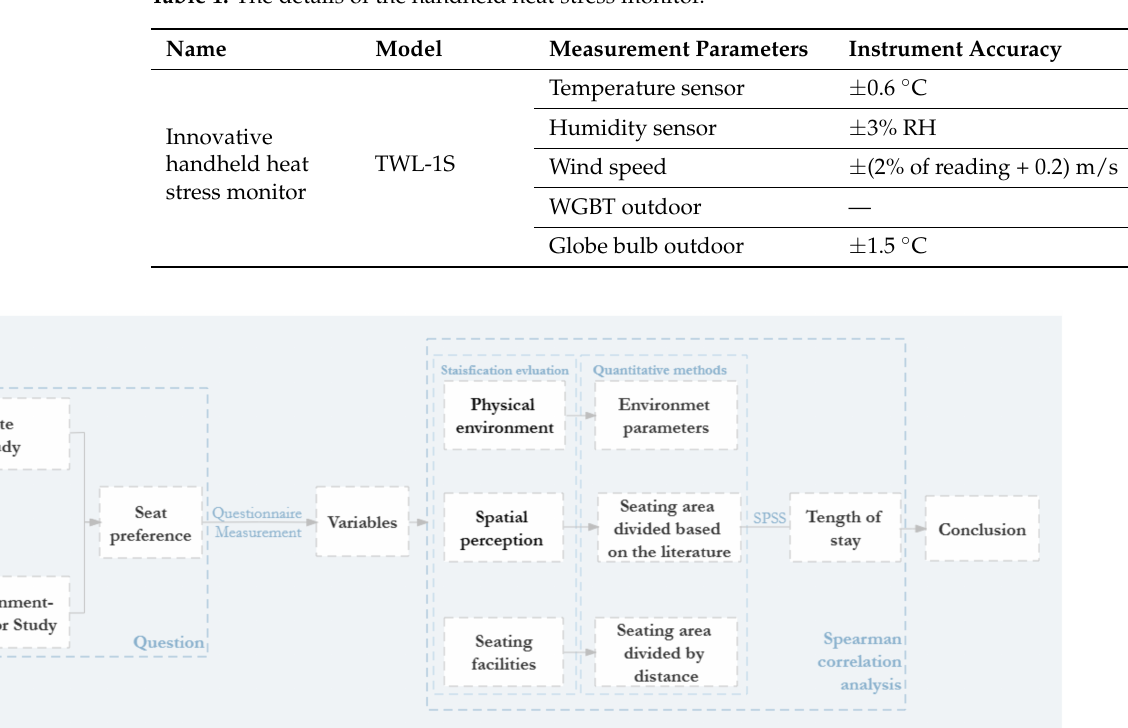
Figure 1. Status of the site: ( a ) aerial view of semi-outdoor space and ( b ) view from the site. Table 1. The details of the handheld heat stress monitor.